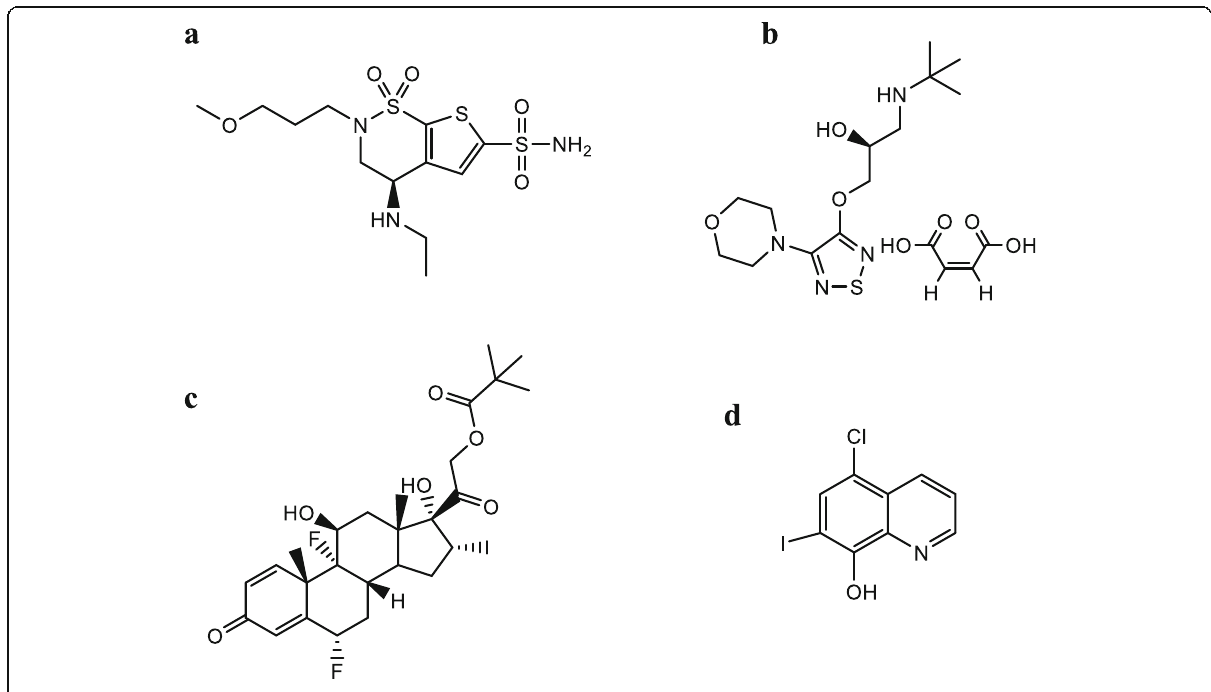
Fig. 1 Chemical structure of brinzolamide (BRZ) ( a ), timolol maleate (TM) ( b ), flumethasone pivalate (FP) ( c ), and clioquinol (CL) ( d